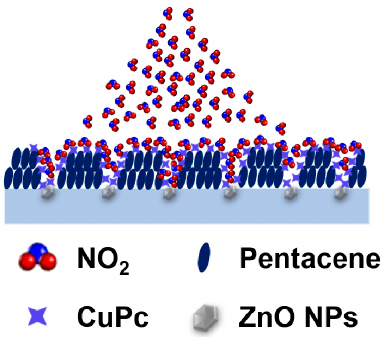
Figure 6. Schematic illustration of ZnO/PMMA hybrid dielectric and CuPc/pentacene heterojunction under NO 2 .